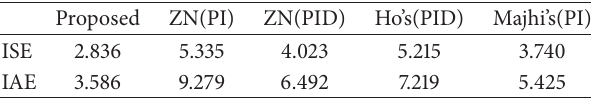
Table 3: The ISE and IAE of five methods for Example 2.